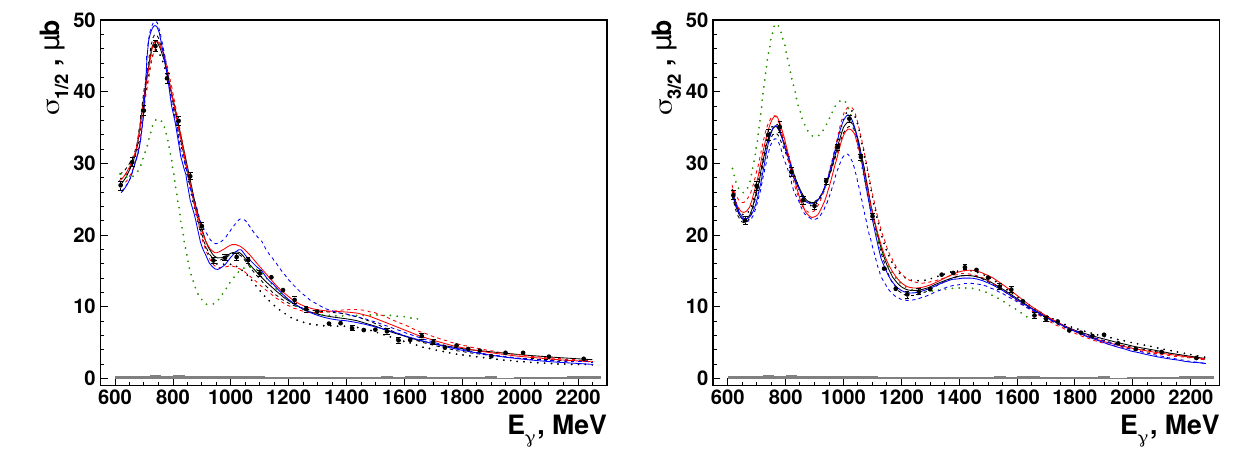
Figure 4. The spin dependent cross sections σ 1 / 2 (left) and σ 3 / 2 (right), which were extracted from the helicity asymmetry E measure- ment, are plotted for the p π 0 final state (black points) together with di ff erent PWA solutions (solutions including this data: BnGa-2014- 02 (black solid) [15], BnGa-2014-01 (black dashed) [41], SAID (PD03) [41] (red solid, curve calculated used solution PD03 for E and CM12 for the cross section), JüBo-2016-01 (blue solid) [41], and not including this data: BnGa-2011-02 (black dotted) [42], SAID CM12 (red dashed) [17], JüBo-2013-01 (blue dashed) [43], MAID2007 (green dotted) [18]). The systematic error is represented by the gray area. Taken from